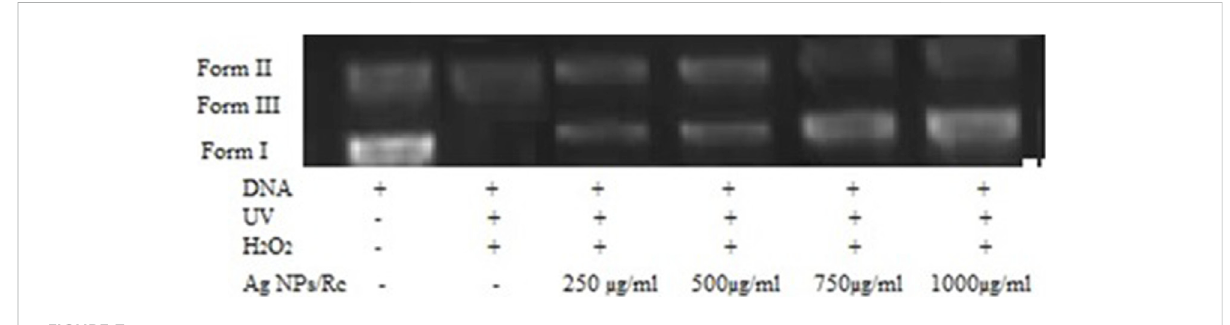
FIGURE 7 Electrophoresis image examining DNA